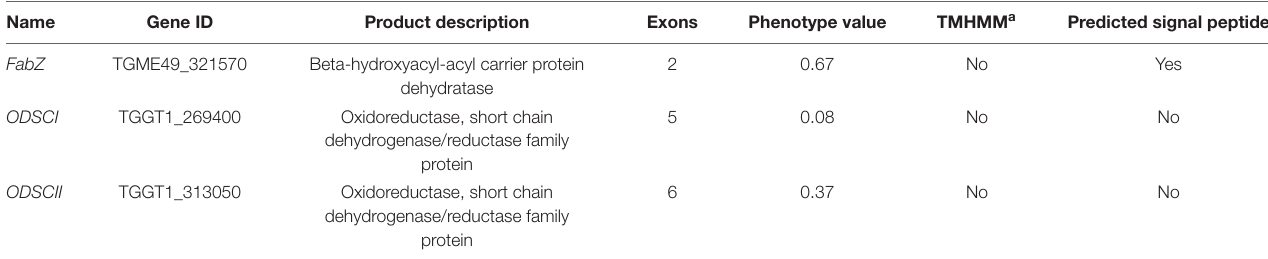
FIGURE 7 | Expression profiles of FabZ , ODSCI , and ODSCII in T. gondii . (A) The temporal expression profile of FabZ , ODSCI , and ODSCII during the cell cycle of T. gondii RH strain. (B) The expression profile of FabZ , ODSCI , and ODSCII of T. gondii in type I (RH and GT1), type II (PRU and ME49) and type III (CTG and VEG) strains of T. gondii . TABLE 1 | Bioinformatic characteristics of Toxoplasma gondii